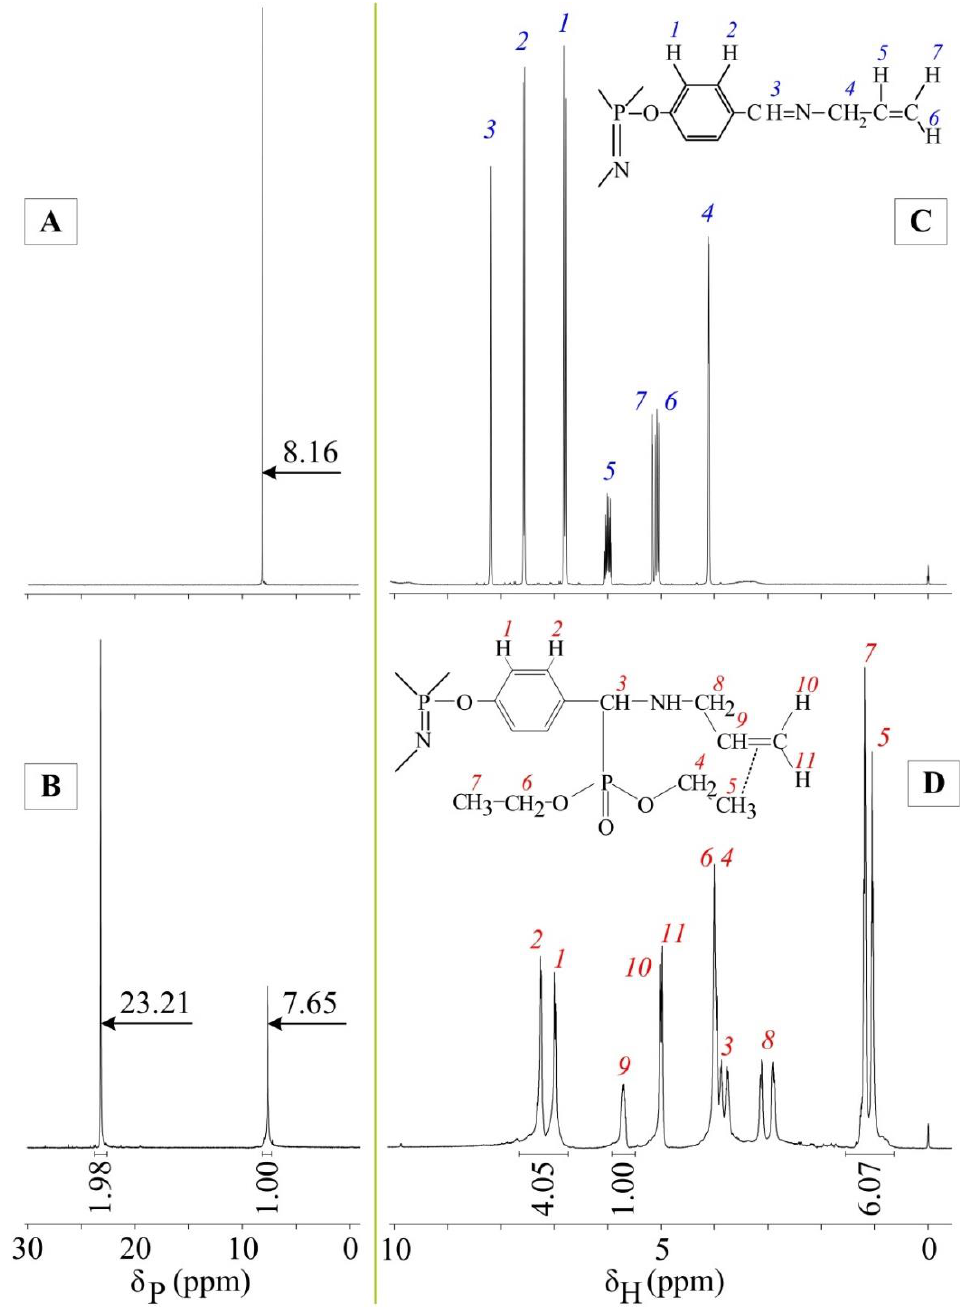
Figure 2. 31 P NMR spectra: APP ( A ), extractant ( B ), and 1 H NMR spectra: APP ( C ) and extractant ( D ).